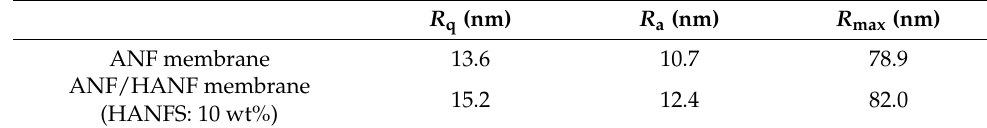
Table 1. The roughness parameters of the ANF membrane and ANF/HANF membrane (HANF composition: 10 wt%).